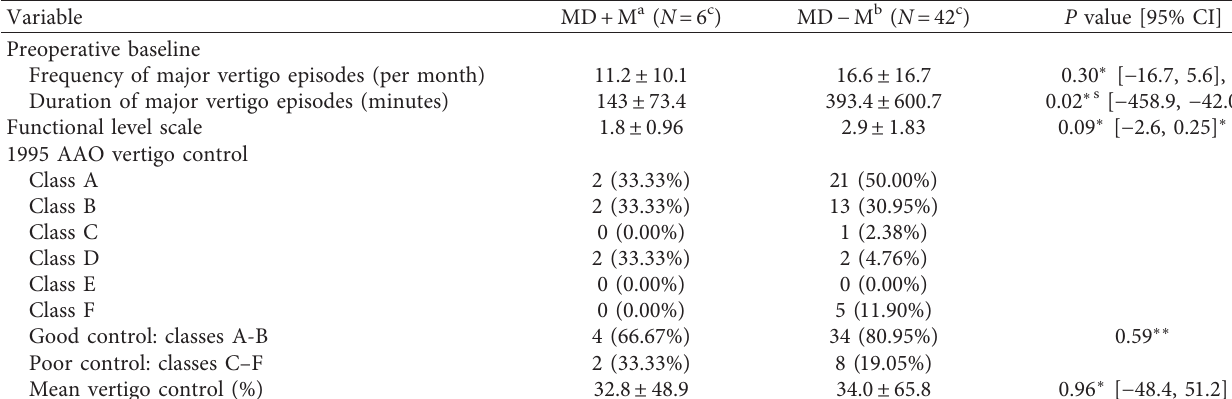
Table 3: Outcomes for endolymphatic sac surgery stratified by migraine as a